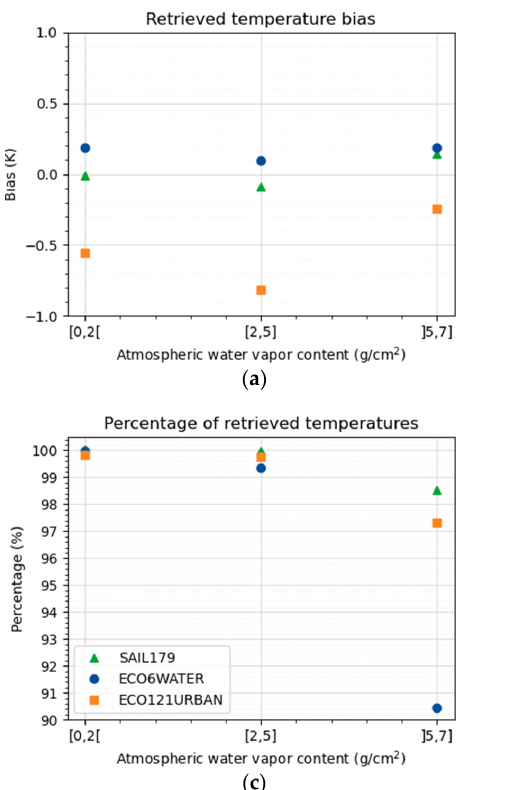
Figure 13. Bias ( a ), RMSE ( b ), and retrieved percentage ( c ) obtained with DirecTES and Δ T (cid:2930)(cid:2918)(cid:2928)(cid:2915)(cid:2929)(cid:2918) = 3 K , with VNIR-SWIR information. These results are given as a function of the atmospheric water vapor content in three categories: dry: AWVC < 2 g/cm 2 , medium: 2 g/cm 2 < AWVC < 5 g/cm 2 , and humid: AWVC > 5 g/cm 2 .